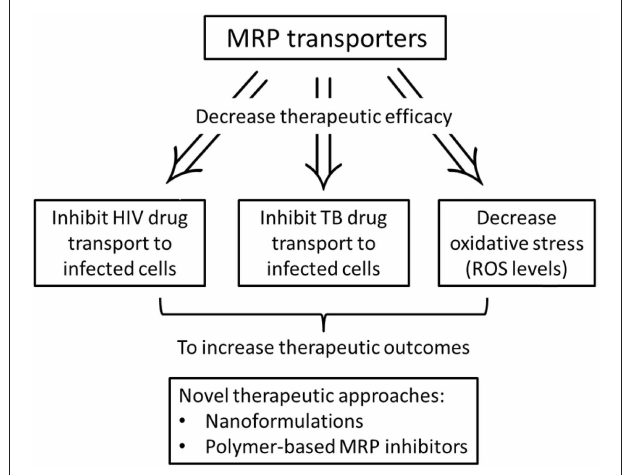
FIGURE 1 | Schematic representation of the role of MRP efflux transporters in HIV-1 and TB